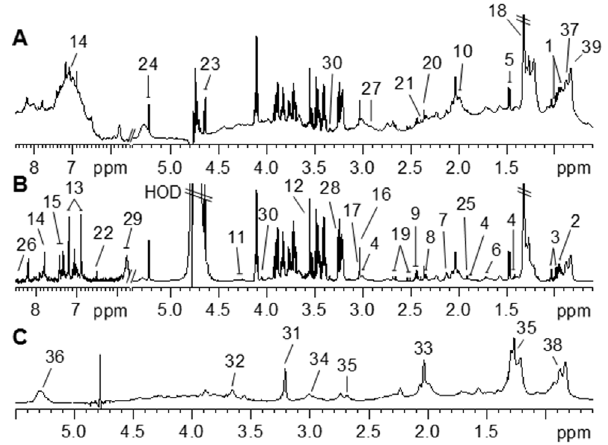
Fig. 2. Typical 600 MHz 1 H NMR spectra of plasma taken from piglets from standard 1D (A), CMPG (B) and BPP-LED (C) experiments. The spectra in the aromatic region were magnified four times (A) ( d 5.7–8.5) or eight times (B) ( d 5.7–8.5) compared to the aliphatic region ( d 0.6–5.4). Keys for metabolites are given in Table 4